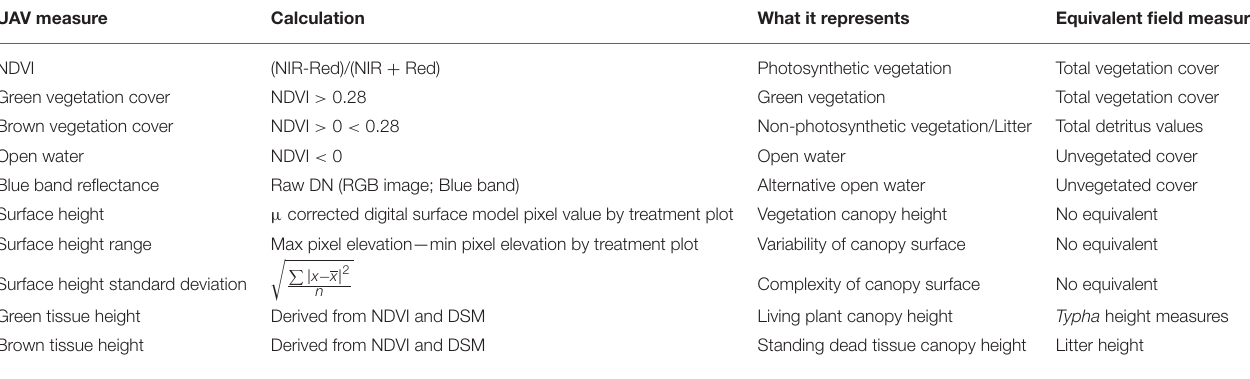
TABLE 1 | Unmanned aerial vehicle collected data and equivalent field